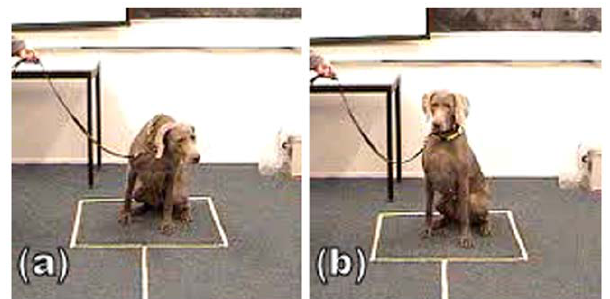
Figure 3. Subject sitting in the designated testing area, looking at the left model (a) and the right model